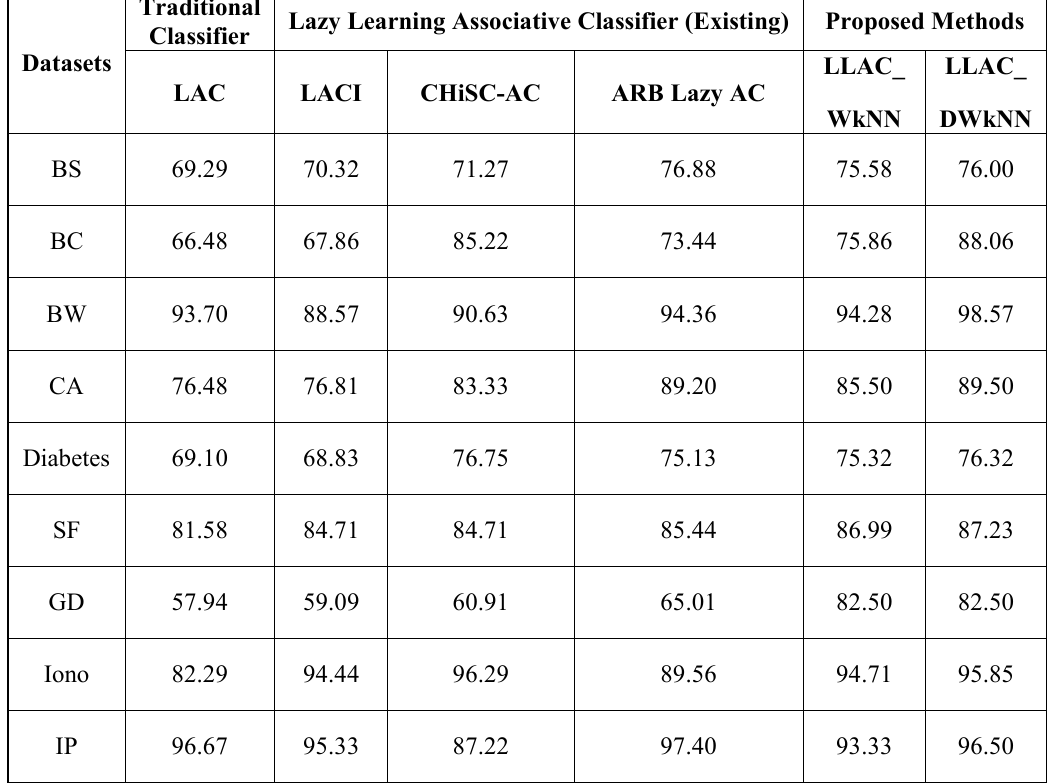
Table 2. Accuracy comparison with traditional and existing systems.